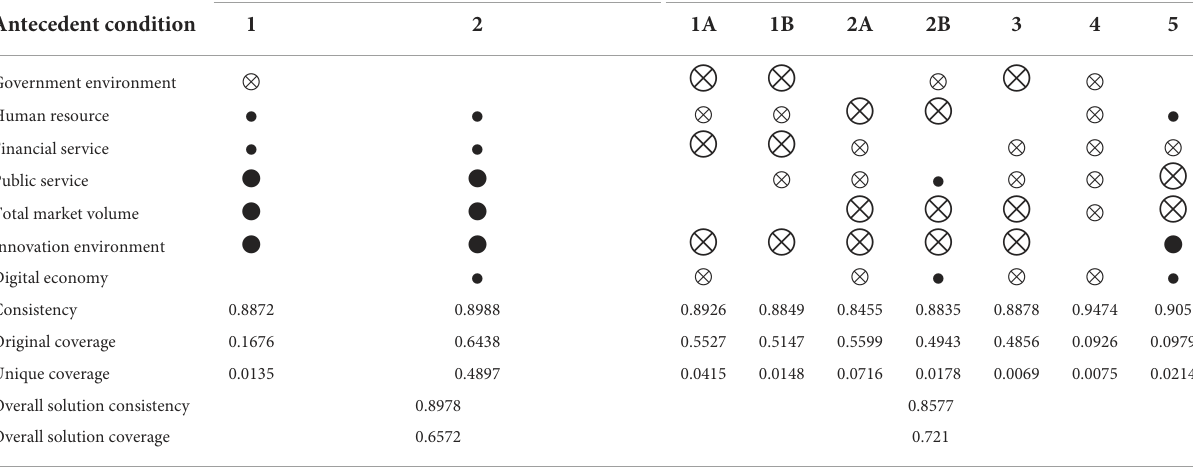
TABLE 6 Configuration path of tourism industry development.